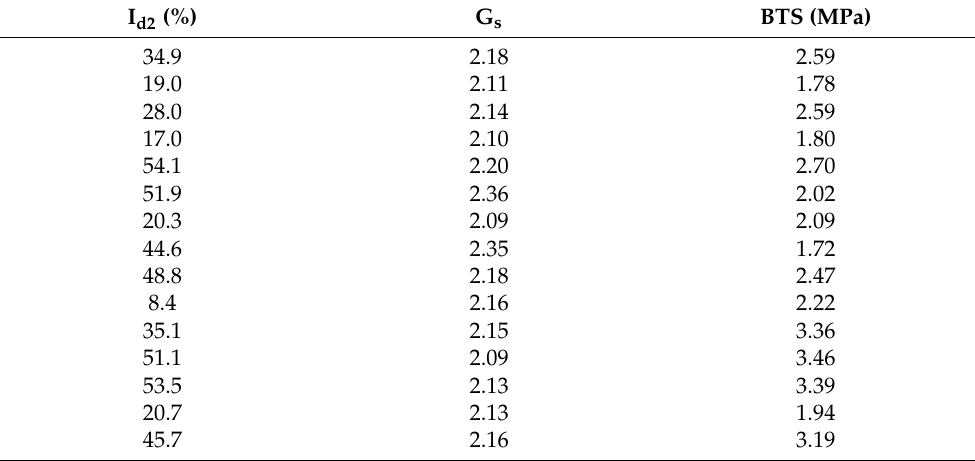
Table 1. Partial data used in the study.